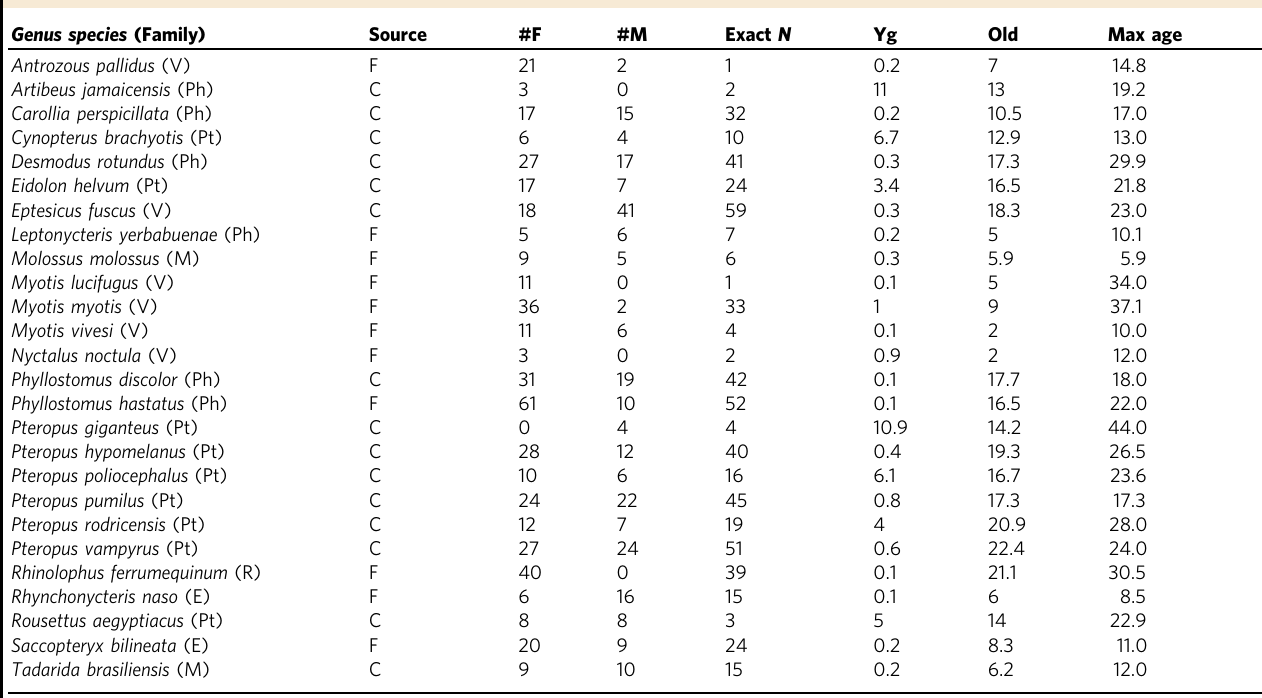
Table 1 Summary a of samples used for DNAm pro fi ling. Genus species